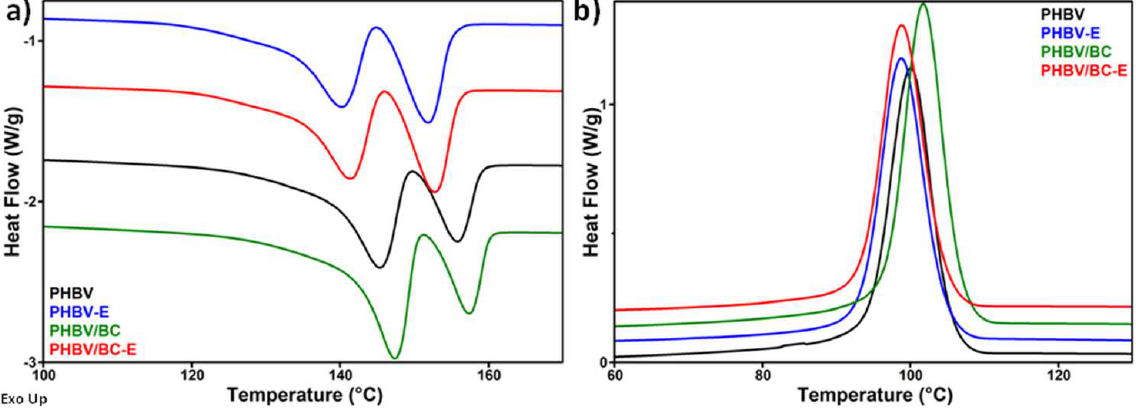
Figure 6. DSC second heating ( a ) and cooling ( b ) curves of PHBV-based materials; curves have been translated for sake of clarity. Table 3. Melting temperatures from the first (T mI ) and second heating (T mII,1,2 corresponding to the double peak) cycles and crystallization temperatures (T c ), together with the corresponding enthalpies ( ∆ H mI , ∆ H mII,1 , ∆ H mII,2 , and ∆ H c ) and degree of crystallinity (X c